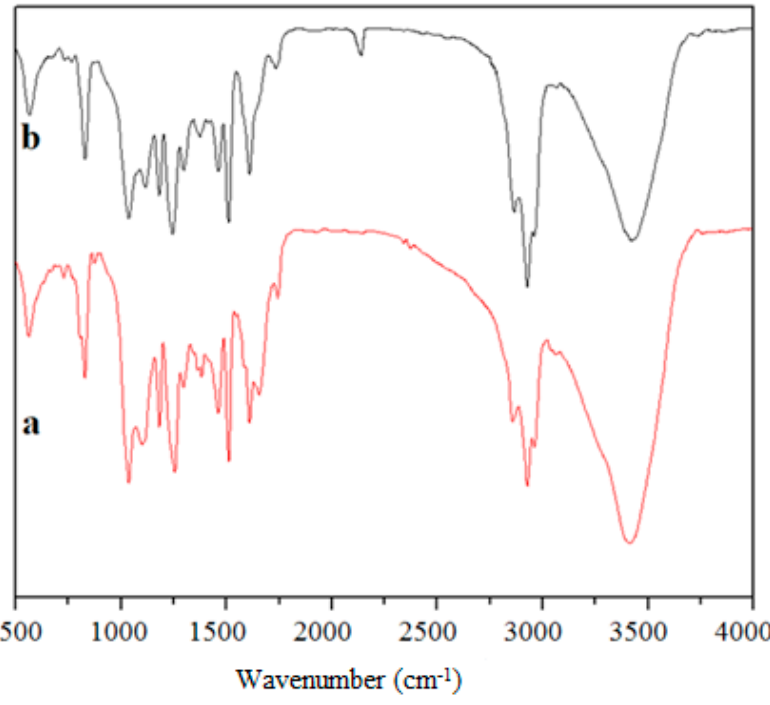
Figure 2. FTIR spectra of a) neat epoxy resin and b) epoxy/UFNBRP nanocomposite.